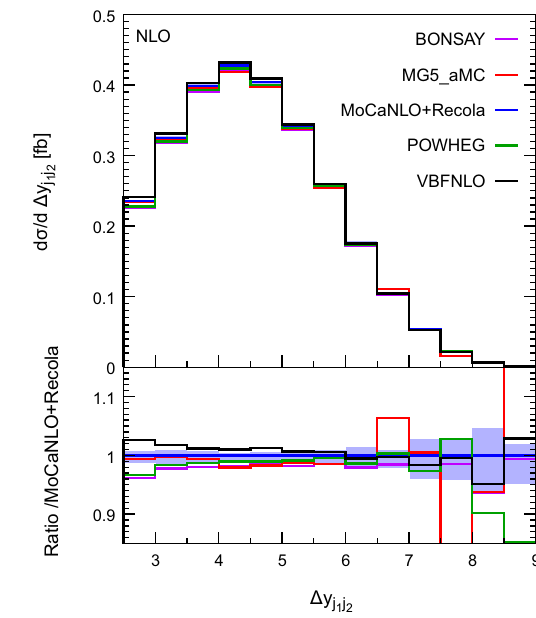
Fig. 10 Differential distributions in the invariant mass (left) and rapid- ity difference (right) of the two tagging jets at NLO accuracy i.e. at order O (α s α 6 ) . The description of the different programs used can be found in Sect. 3.2. The upper plots provide the absolute value for each prediction while the lower plots present all predictions normalised